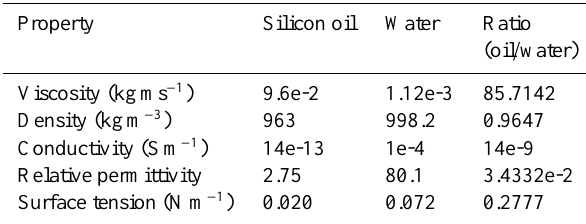
Table 1. Physical properties of employed